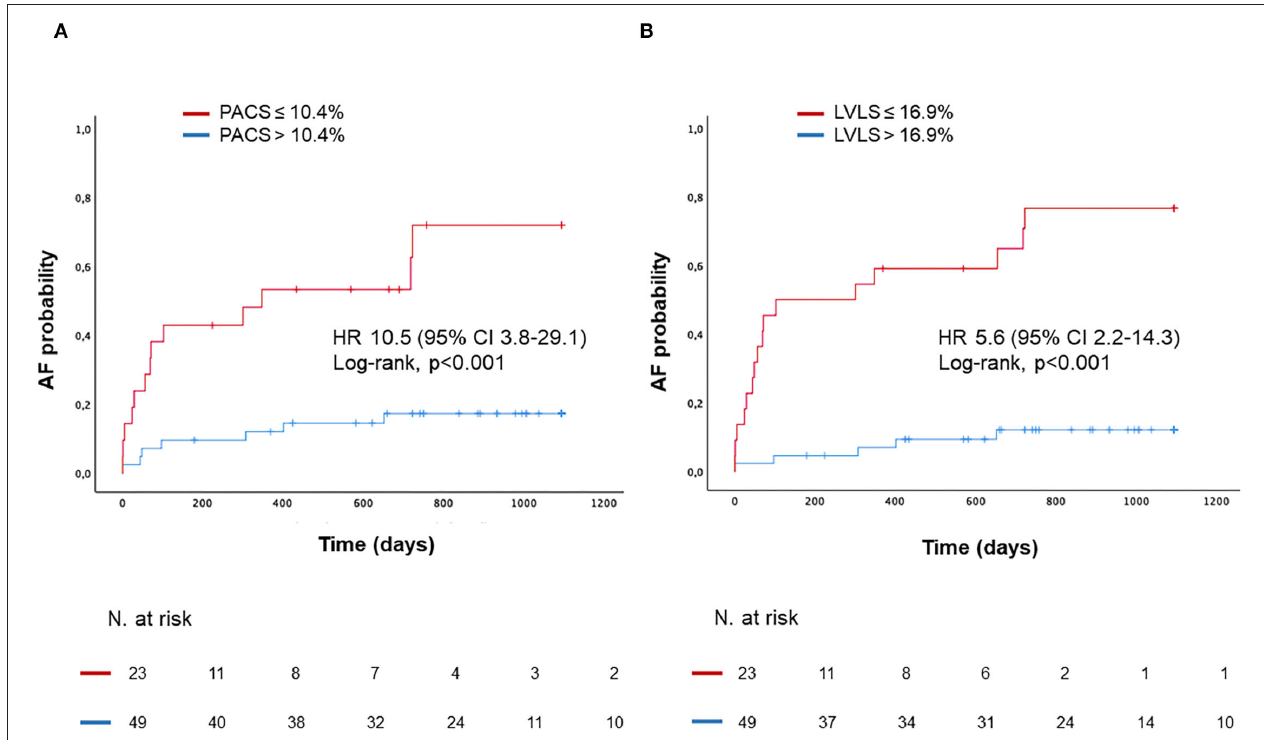
FIGURE 4 | Kaplan–Meyer estimates of AF probability according to PACS (A) , or according to LVLS (B) . HR, Hazard